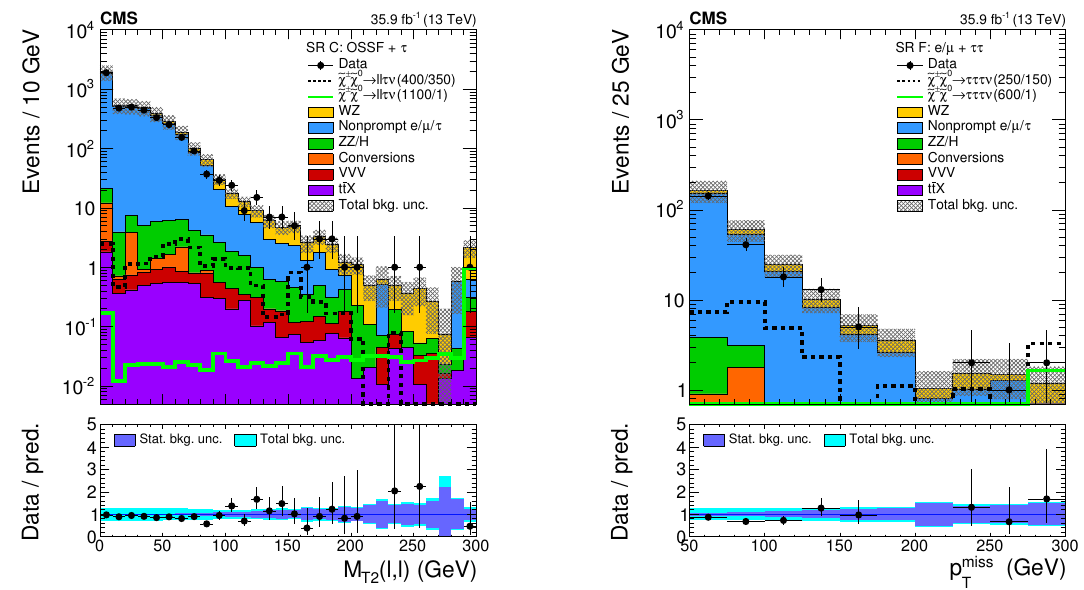
Figure 6 . Distributions in the stransverse mass for events with two OSSF light leptons and one (cid:28) (left) and in p miss for events with one light-(cid:13)avor lepton and two (cid:28) h s. Two signal mass points in the T (cid:28) -enriched (left) and the (cid:28) -dominated (right) scenarios with mass parameter x = 0 : 5 are displayed for illustration. The notation is analogous to that used in (cid:12)gure 4.